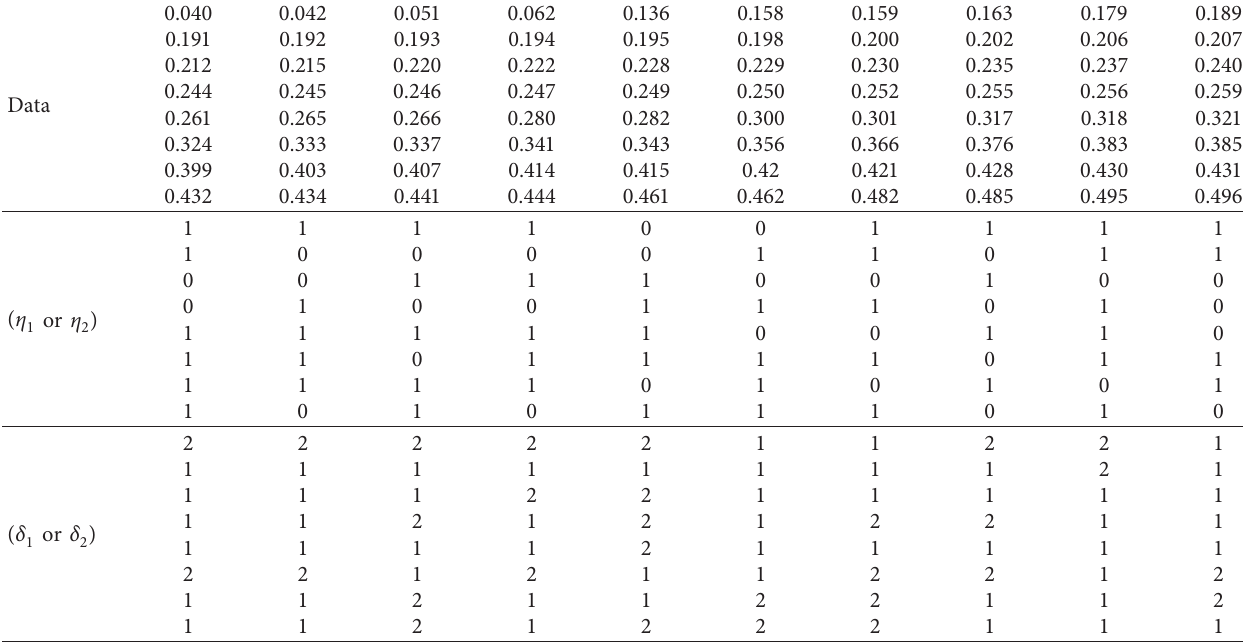
Table 2: Type-I JCRS from heal data with τ � 0 .